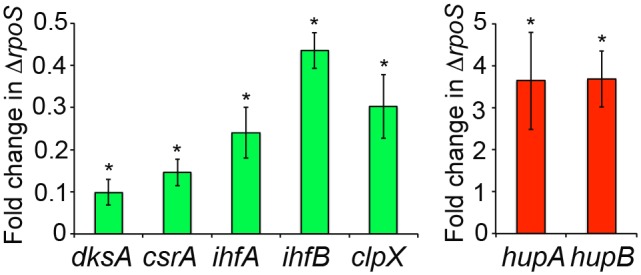
σS-dependent transcriptomic expression of pleitropic regulators.Verification of the σS-dependent transcriptomic expression of csrA, dksA, ihfA, ihfB, hupA, hupB and clpX by quantitative RT-PCR. RNA extracted from stationary phase LB cultures (18 h) of Salmonella wild-type and ΔrpoS strains (VF7969 and VF9356) was reverse transcribed to cDNA and used as a template for qRT-PCR. rpoZ was used for normalization. Red and green bars correspond to genes negatively and positively controlled by σS, respectively. Three biological replicates were analysed in duplicate each and error bars display the standard error of the mean. *, expression levels in the ΔrpoS mutant significantly different from that in the wild-type strain (p<0.05).